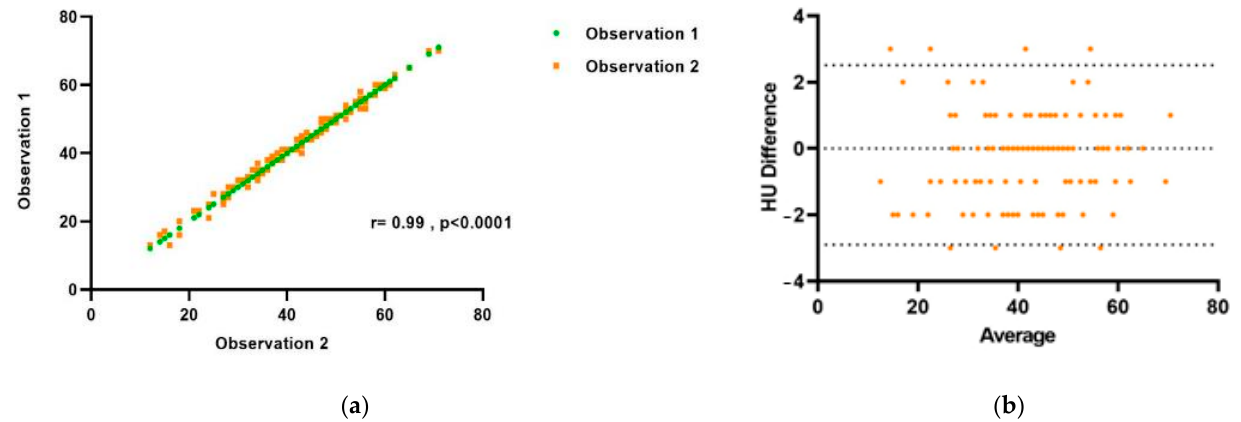
Figure 6. Results of Intra-observer reproducibility testing for liver HU measurement, shown using Pearson correlation coefficient ( a ) and Bland–Altman analysis ( b ).